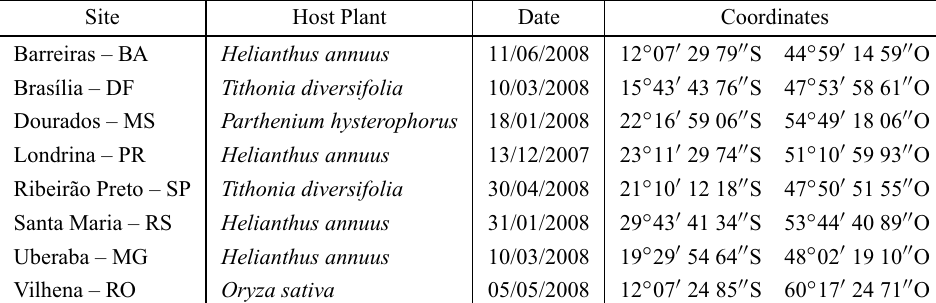
Data on Chlosyne lacinia saundersii collection